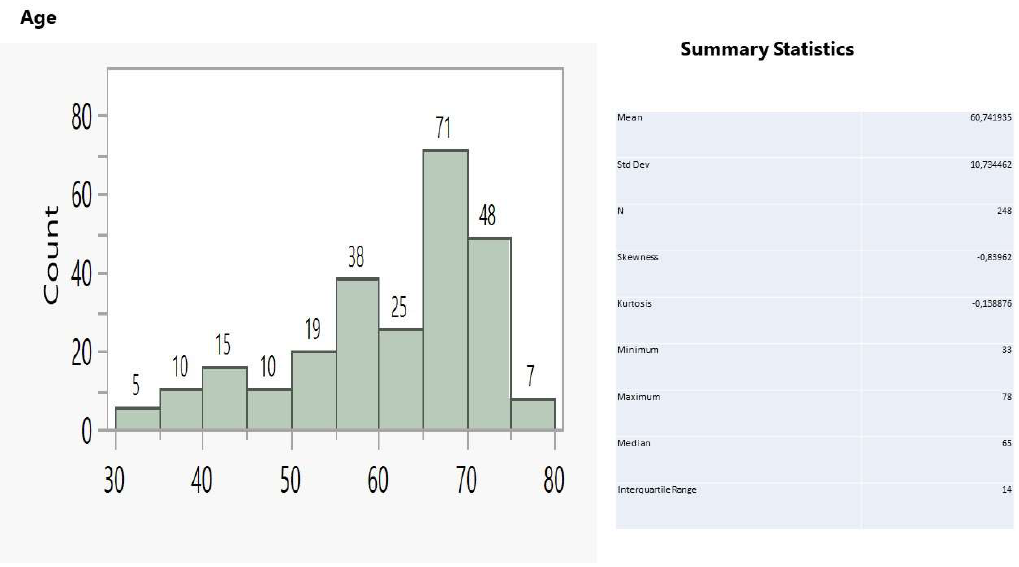
Figure 5. Age distribution and relevant statistics.